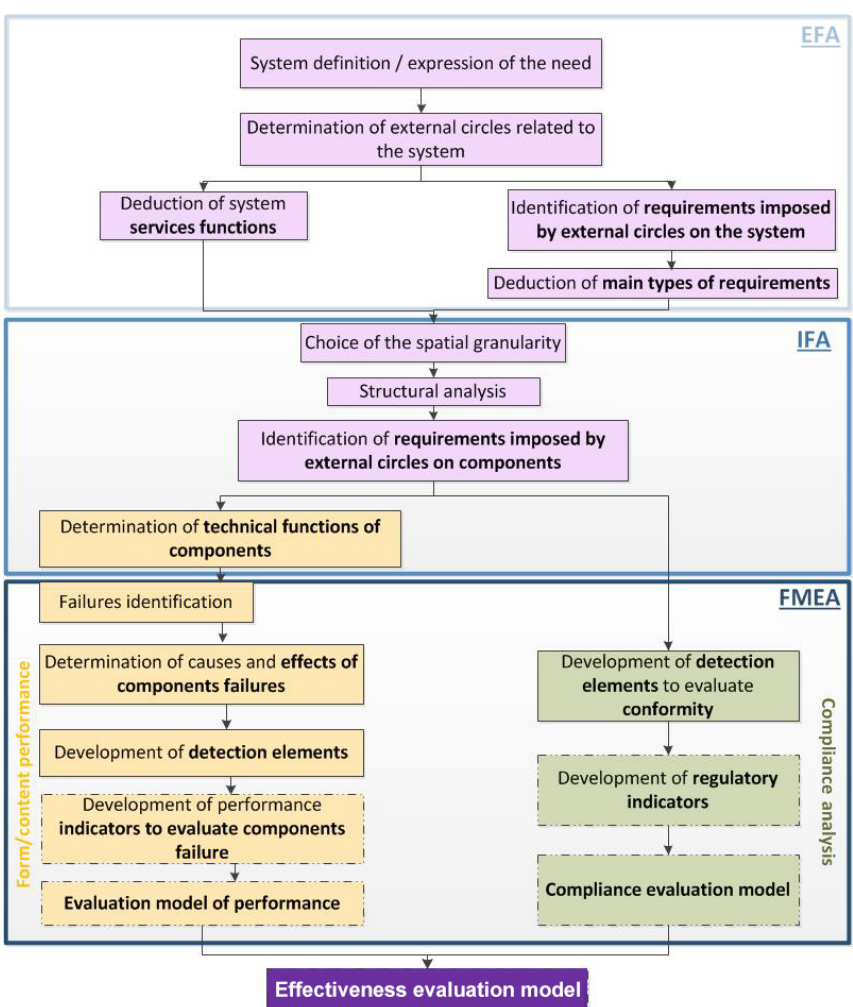
Figure 2. Global methodology proposed and followed to build the effectiveness evaluation model: detailed steps leading to the detection elements. Dotted boxes show future